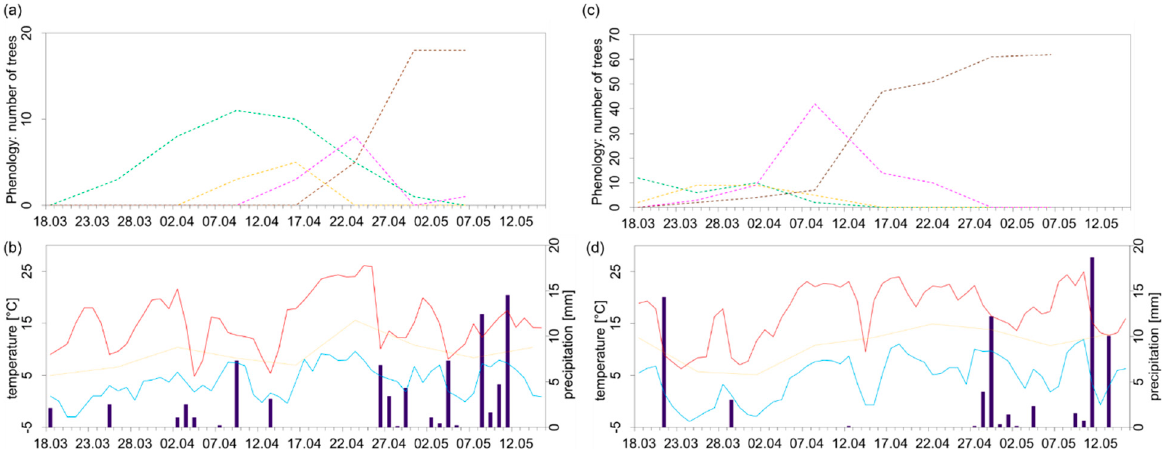
Figure 4. Phenological observations in relation to temperature [ ◦ C] and precipitation [mm] during the ash flowering at the location Schorndorf in 2019 ( a , b ) and 2020 ( c , d ). ( a , c ) Phenological observations: BBCH 60 + 61—beginning of pollen release: max. 10% of flowers release pollen (dashed green line); BBCH 65—full flowering: >50% of flowers release pollen (dashed orange line); BBCH 68—end of flowering and pollen release (dashed pink line) and BBCH 69—no more pollen release (dashed brown line). ( b , d ) daily maximum (red line) and minimum (light blue line), and mean (yellow dotted line) of temperature [ ◦ C] and daily precipitation sum [mm] (dark blue bars).